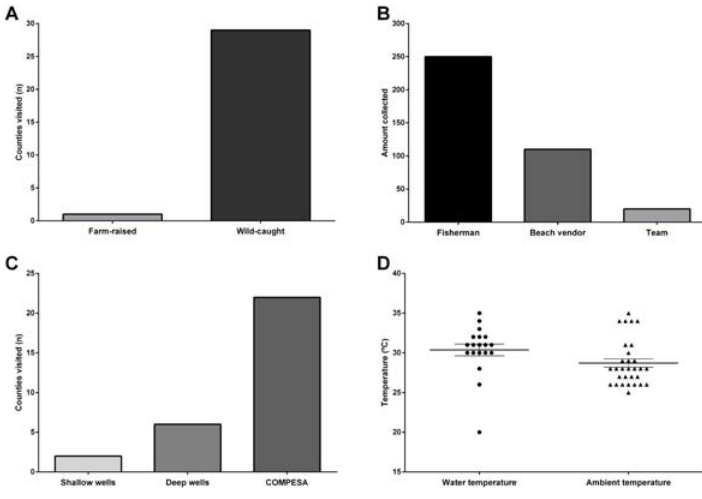
Figure 3 . Sample characteristics. A , Source of shell fi sh. B , Origin of samples obtained. C , Source of water consumed by the population. D , Water and ambient temperature at time of collection. COMPESA: community water system